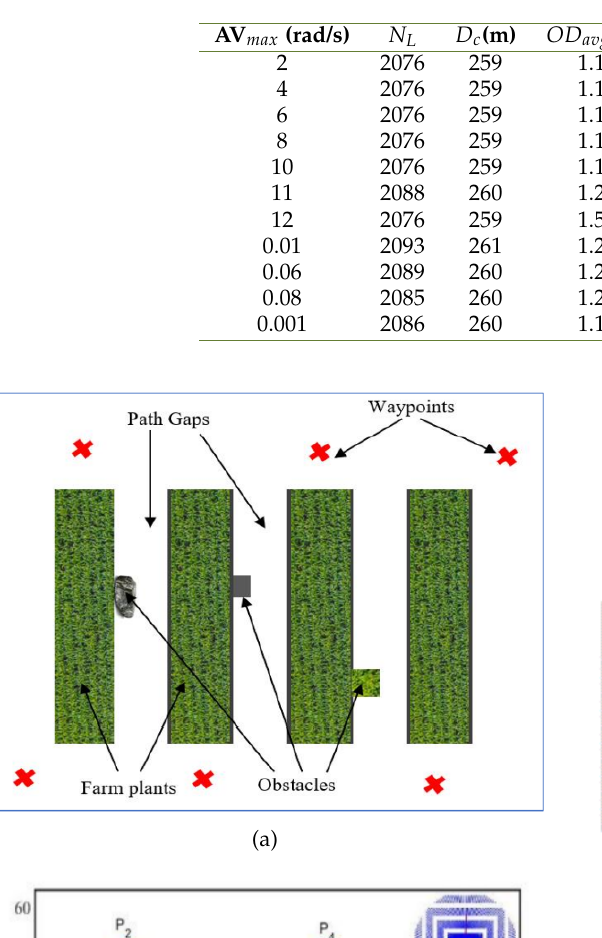
OD avg = 0.98 m when the D LV =0.5 Km/Hr. The maximum value of OD avg =1.40 m when D LV =1.5 Km/Hr. Minimum value of N L = 973 when D LV =2.75 Km/Hr. Maximum value of N L =4988 when D LV =0.5 Km/Hr. Least distance D C = 249 m when D LV = 0.5 Km/Hr and maximum D C =267 m when D LV = 2.5